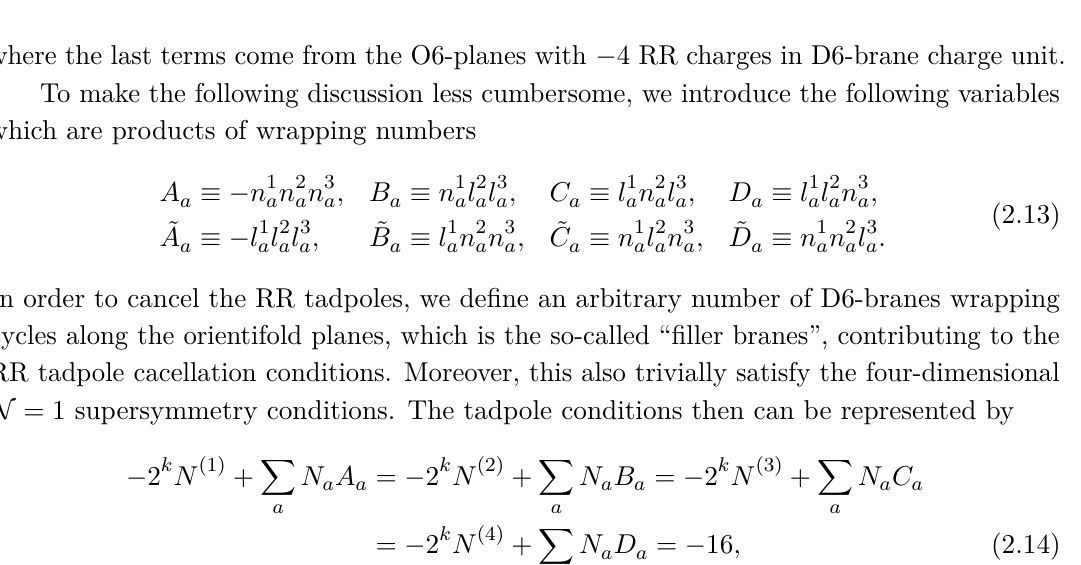
Table 1 . General massless particle spectrum for intersecting D6-branes at generic angles. The second column lists the representations of the resulting gauge symmetry group U( N Z orbifold projection [21]. The chiral supermultiplets include both scalars and fermions in × Z 2 2 this supersymmetric constructions. And we choose the positive intersection numbers to denote the left-handed chiral supermultiplets as